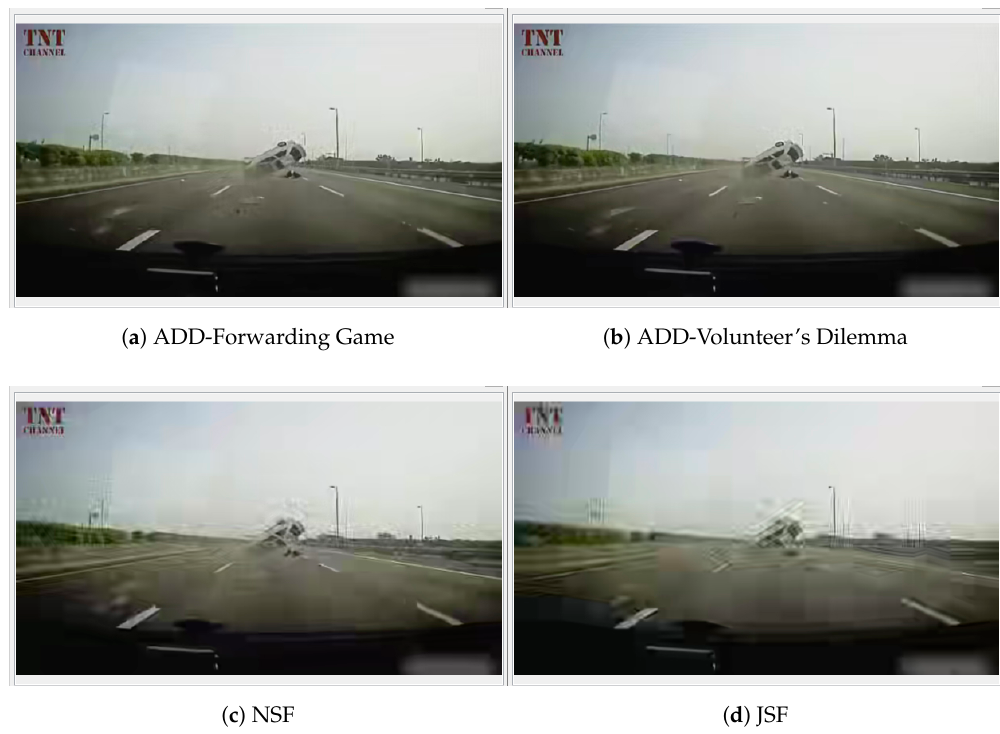
Figure 8. Comparison sample for the different simulated protocols at frame 72 in RSU 4 located at 1200 m with 100 vehicles/km 2